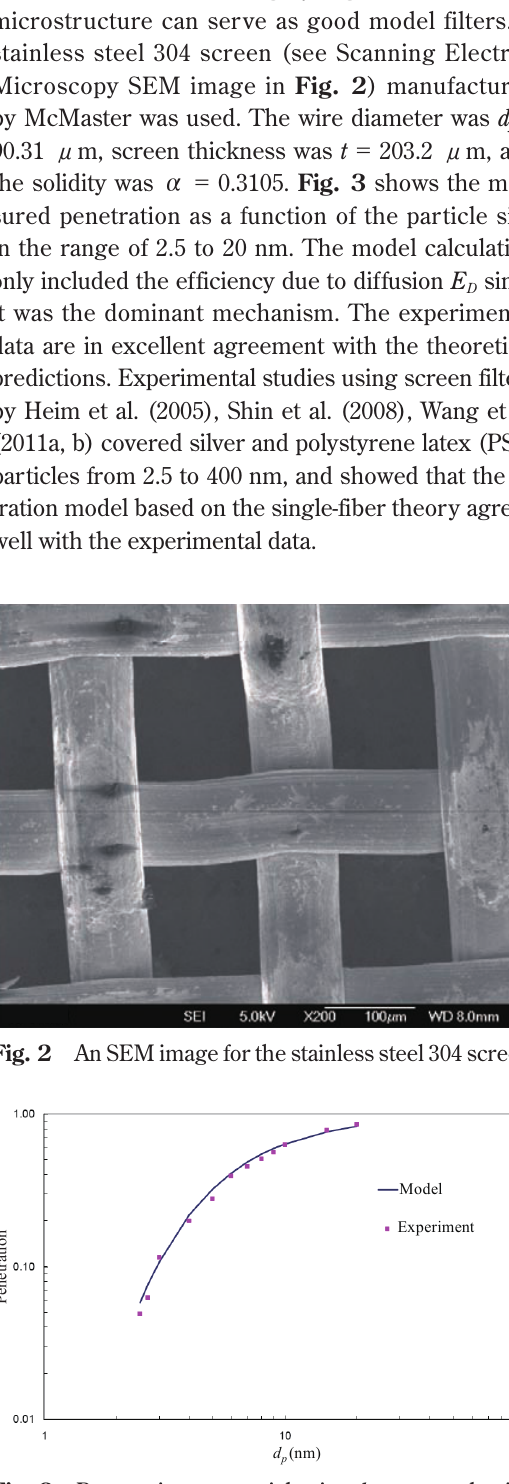
Fig. 3 Penetration vs. particle size d the model screen filter.